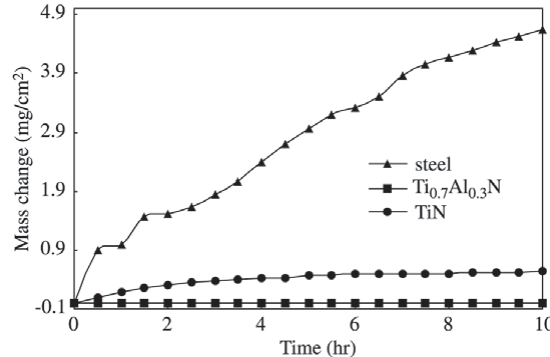
Figure 7. Corrosion kinetics of steel 1Cr11Ni2W2MoV coated with coatings Ti Al N under synergistic effect of solid NaCl and 1-x x water vapor at 600